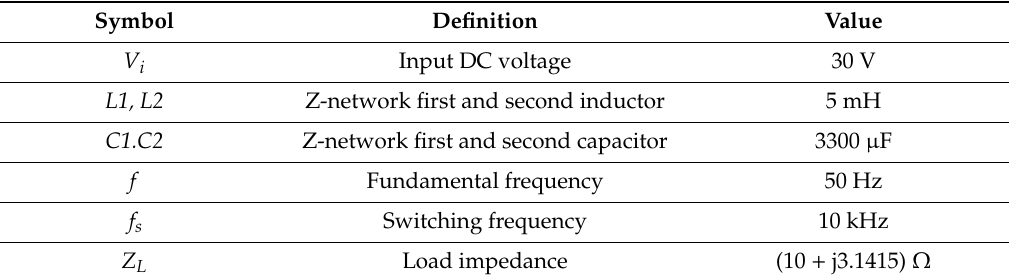
Table 2. Simulation